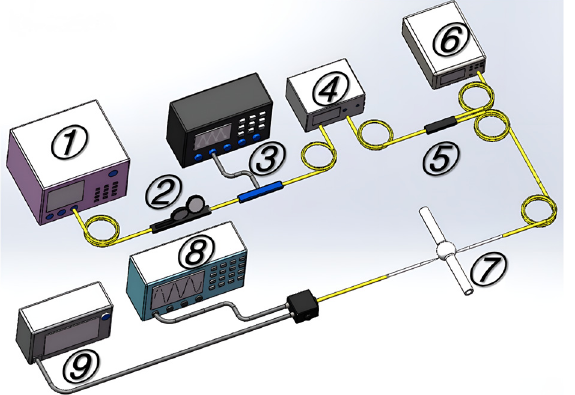
Figure 2. The experimental measurement setup. 1. tunable laser; 2. polarization controller; 3. EOM; 4. EDFA; 5. 1/99 Fiber coupler; 6. power meter; 7. fused tapered fi ber with microbubble cavity; 8. oscilloscope; 9.